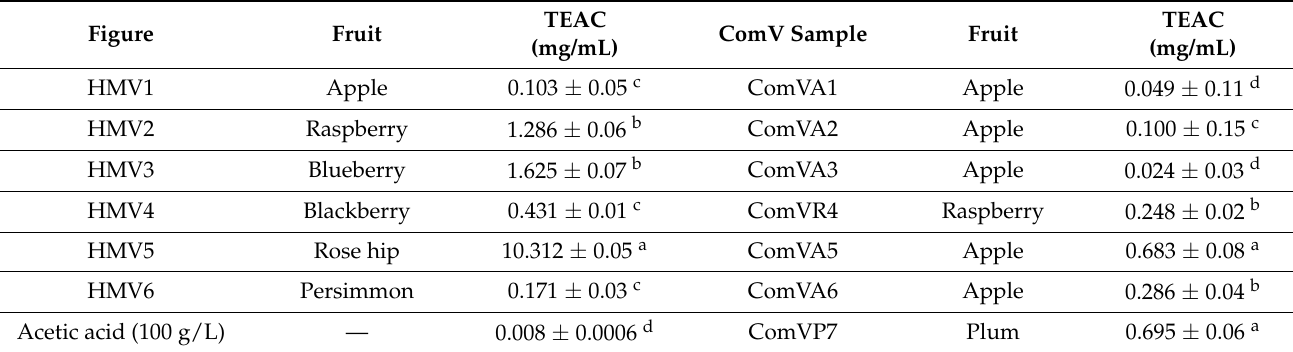
Table 2. Trolox equivalent antioxidant capacity (TEAC) (mg/mL) of final homemade fruit vinegars (HMV) (after two months (60 d) of fermentation) and commercial vinegars (ComV). The samples are apple vinegar (HMV1); raspberry vinegar (HMV2); blueberry vinegar (HMV3); blackberry vinegar (HMV4); rose hip vinegar (HMV5); persimmon vinegar